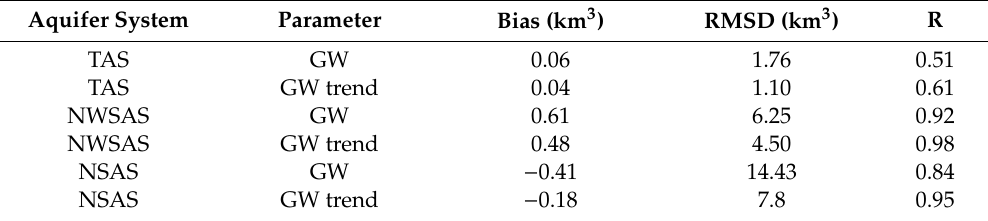
Table 2. Statistical results (bias, RMSD and R) of the comparison between the di ff erent groundwater (GW) volume anomalies using SM GLEAM 3.3b and RL06 mascon GRACE-based TWS (CSR and JPL CRI) (and lake volume for NSAS) in the TAS, NWSAS and NSAS between January 2003 and December 2016 for the volume anomalies and July 2003–June 2016 for the associated